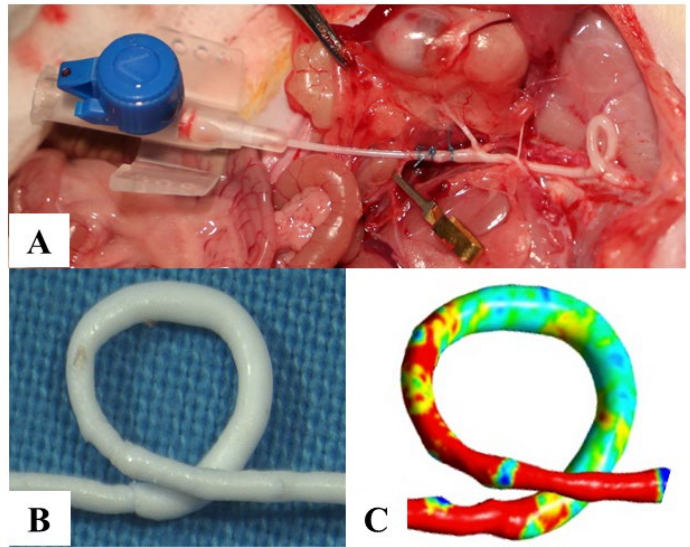
Figure 2. Main steps of the plastic casting process. ( A ) The graft was injected with the plastic from the right common iliac artery. ( B ) The plastic casting with the tissue removed. ( C ) The digitalized 3D vessel model. Magnification: 4×, 10×.